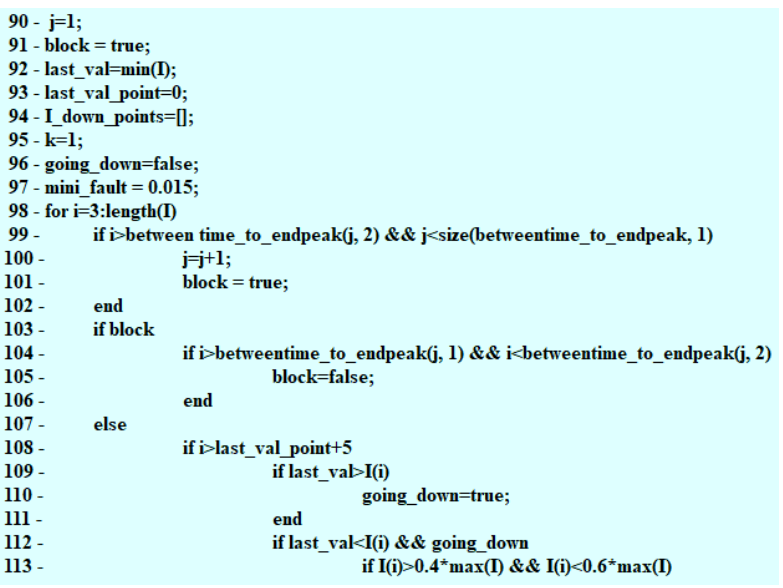
Figure 2. Observation of the changes in current intensity.